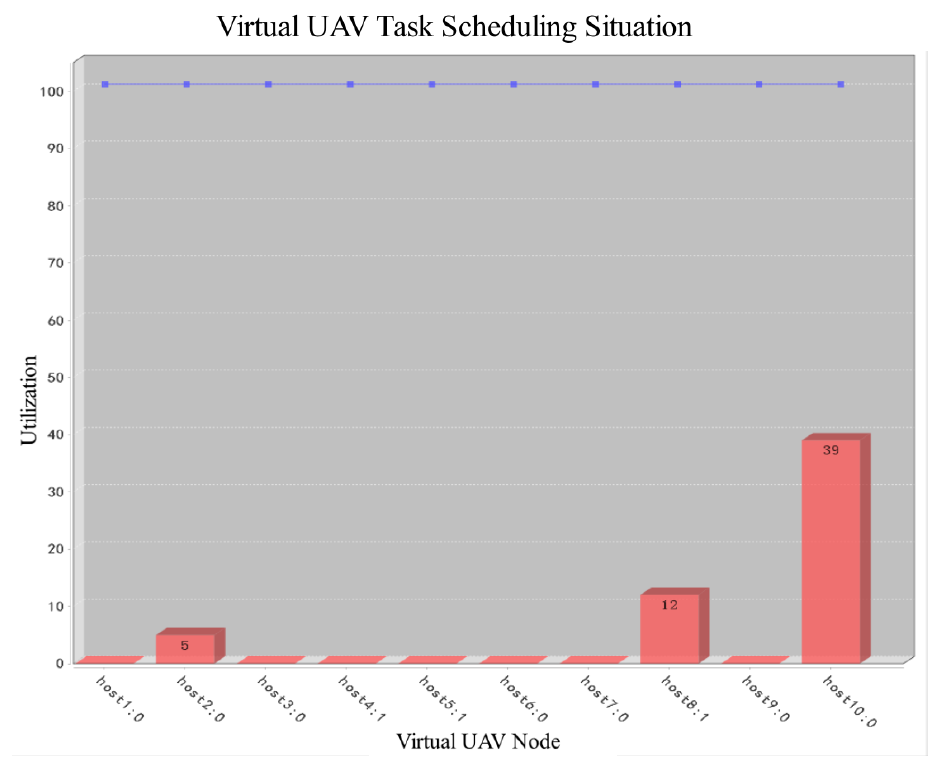
Figure 7. Failure point scheduling